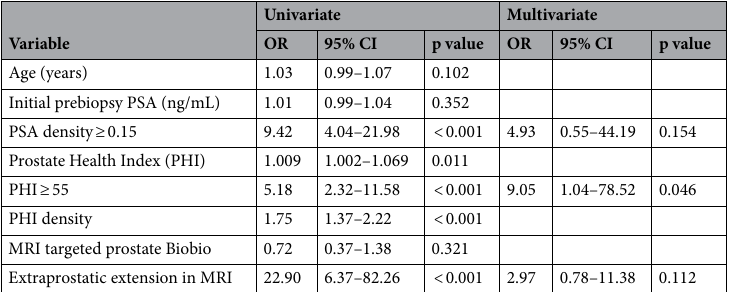
Table 3. Logistic regression analysis for predicting adverse pathologic features at RP (adverse pathologic features: ≥ pT3a or Gleason score ≥ 4 + 3). OR odds ratio, CI confidence interval, PSA prostate specific antigen, MRI magnetic resonance imaging, PIRADS prostate imaging reporting and data